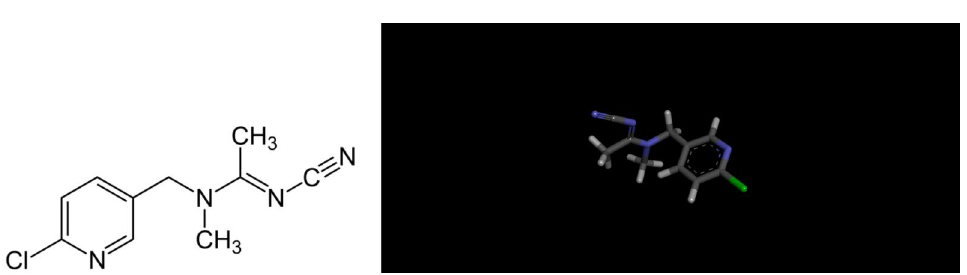
Figure 14. Acetamiprid Structure.